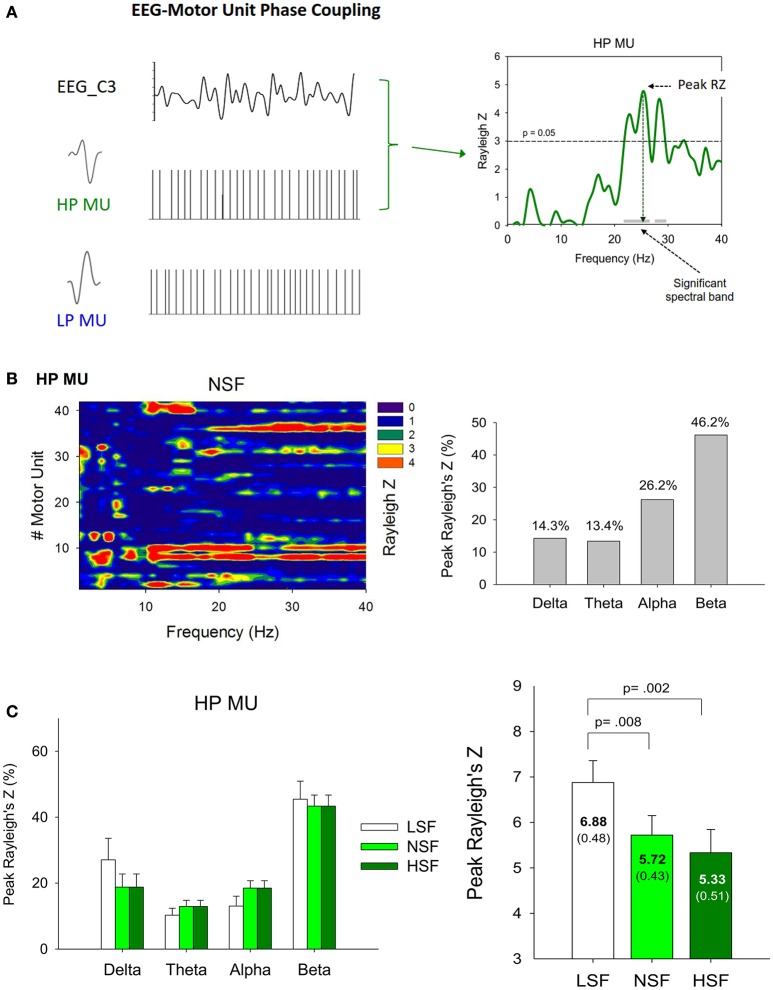
(A) Analysis of phase synchronization between a single high phasic (HP) motor unit (SMU) with oscillatory EEG activity of the C3 electrode (EEG C3). The left column is an example of an EEG and a single high phasic and low phasic motor unit recording. To quantify the cortical entrainment of the spike timing for the SMU, the Rayleigh z-statistic was calculated for each frequency component of the EEG signal and the timing of motor unit action potentials. The phase-locking profile of the representative HP motor unit is shown in the right column. (B) Summary of high phasic motor unit-EEG C3 phase locking for a typical participant in the normal scaling factor condition. The left plot summarizes the results of analyzing the HP motor unit-EEG C3 phase locking for all five experimental trials from a typical participant. The right plot represents the percentage of the spectral bands [delta (1–3 Hz), theta (4–7 Hz), alpha (8–12 Hz), and beta (13–35 Hz)] wherein the peak Rayleigh's Z of phasic motor units occurred. (C) The contrast of the population means of the percentages of the spectral bands wherein the peak Rayleigh's Z of high phasic motor units occurred and peak Rayleigh's Z among the different feedback conditions. (LSF, low scaling factor, NSF, normal scaling factor, HSF, high scaling factor).